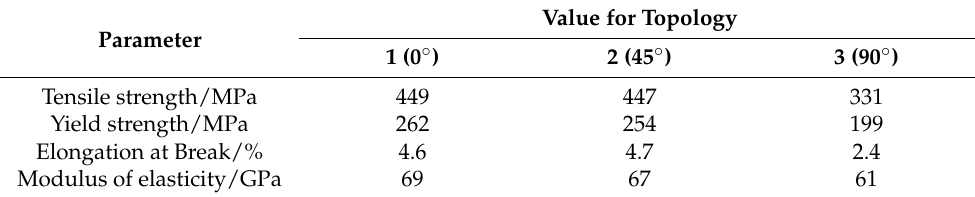
Table 5. Tensile testing results.